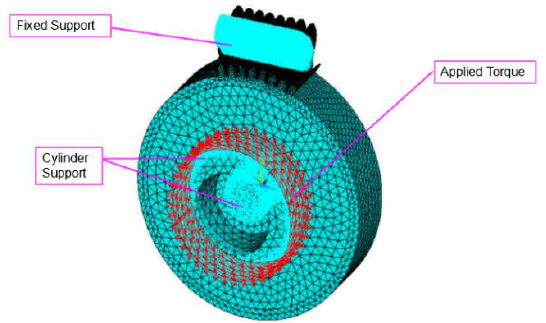
Figure 13. Boundaries of the FEA.